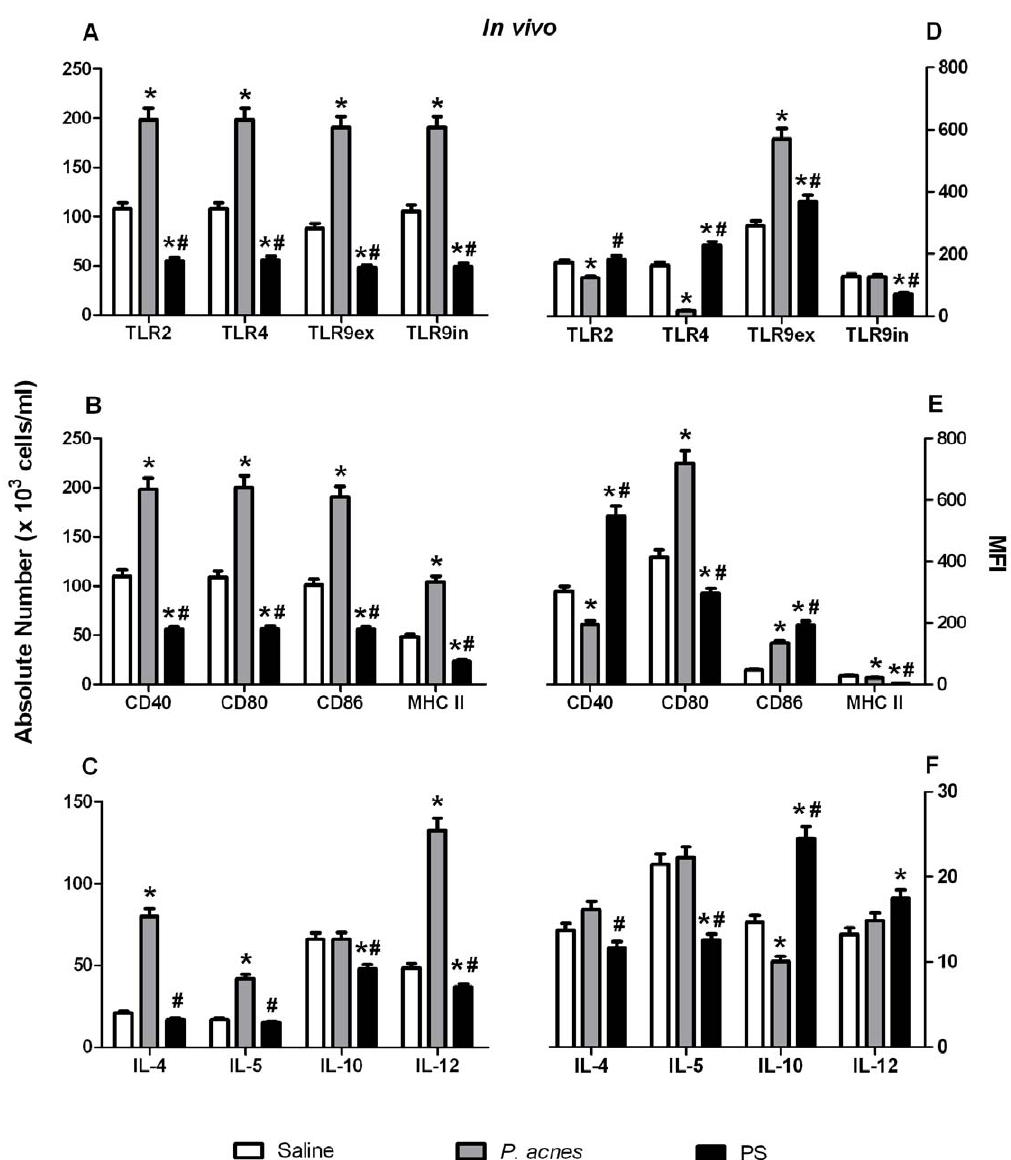
Figure 2. Analysis of the activation status of B-1b lymphocytes invivo . Cells from P. acnes -, PS- or saline- (control group) treated mice were analyzed 24 h after treatment to determine TLR, co-stimulatory molecule, MHC II and cytokine expression by B-1b lymphocytes. The cells were stained with mAbs to determine the absolute number (A to C) of B-1b lymphocytes that expressed each molecule and the mean fluorescence intensity (MFI) of each marker (D to F). The absolute cell number and MFI are the means of two independent experiments with similar results.* p , 0.05 between the control and treated groups. # p , 0.05 between the P. acnes and PS treated groups.